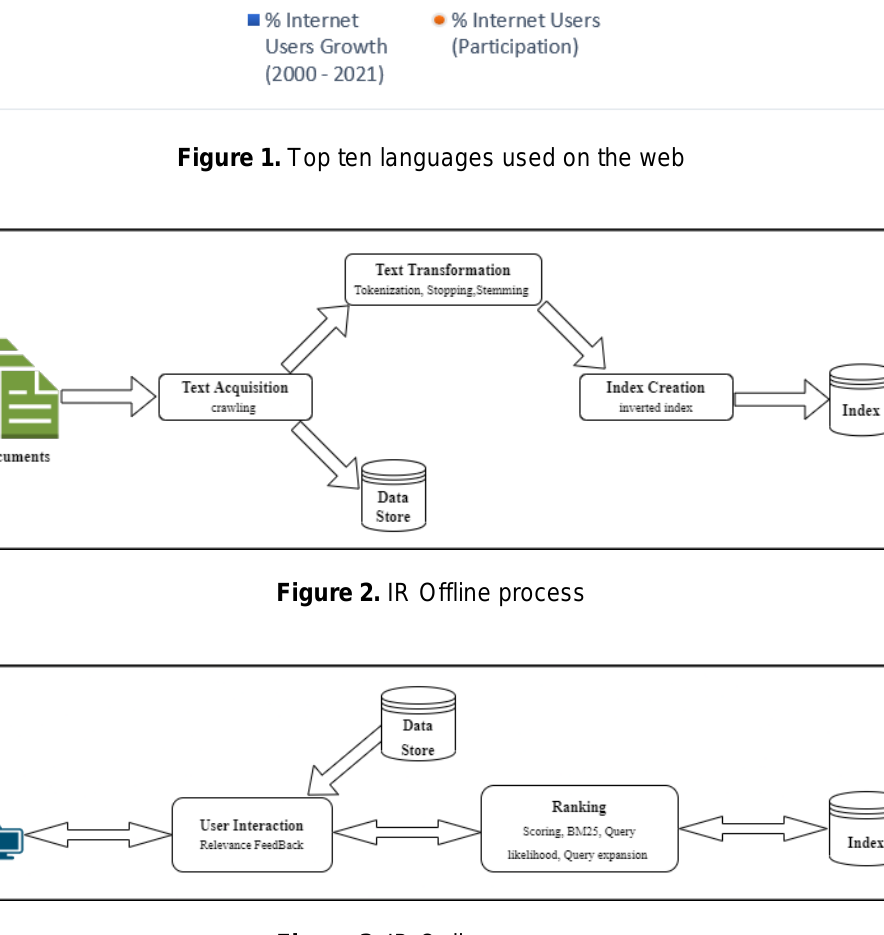
Figure 3. IR Online